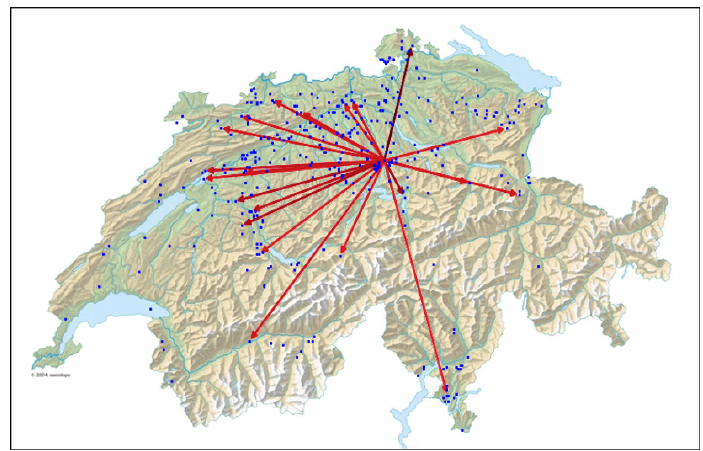
Figure 4. Example of a set of edges obtained by the group LASSO approach for a node in central Switzerland with a past history horizon of three